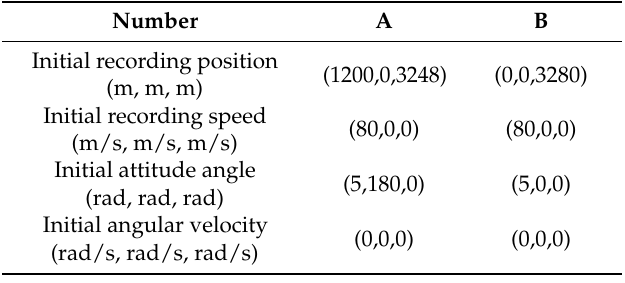
Table 6. Initial state.